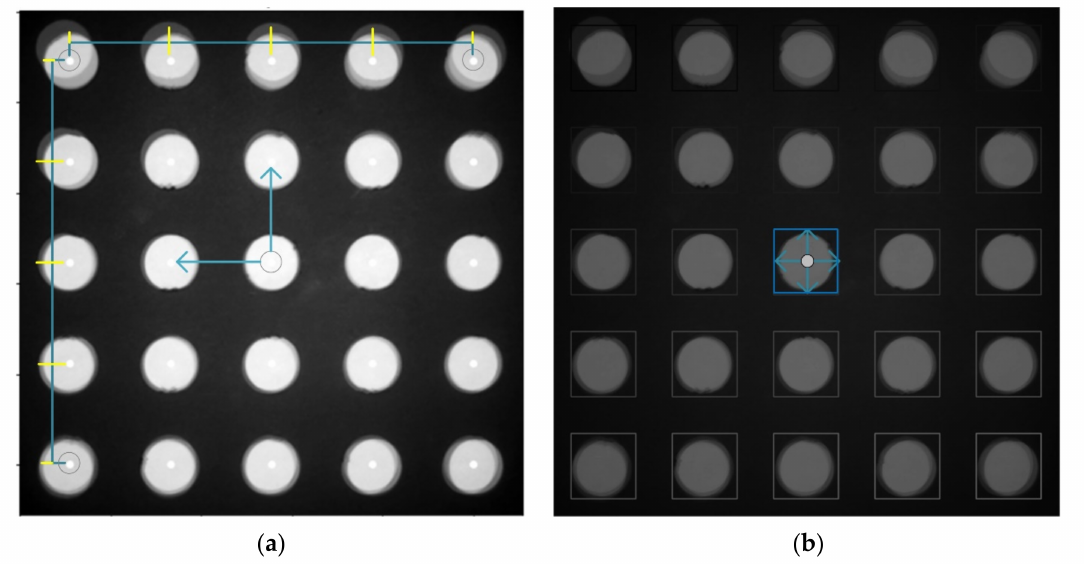
Figure 6. Fluorescence brightness extraction process of the merged image: ( a ) Extraction of 25 tube center positions by bilinear interpolation. ( b ) ROI of each